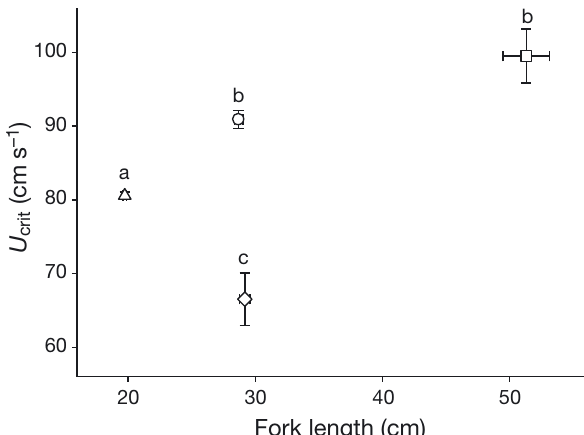
Fig. 2. Critical swimming speed (U crit ) and fork length meas- ured in groups of Atlantic salmon using the large tunnel in small post-smolts (triangle), large post-smolts (circle), adults (square), and large post-smolts tested individually in the small tunnel (diamond). Different letters indicate a statistical difference in U crit . Data are mean ±